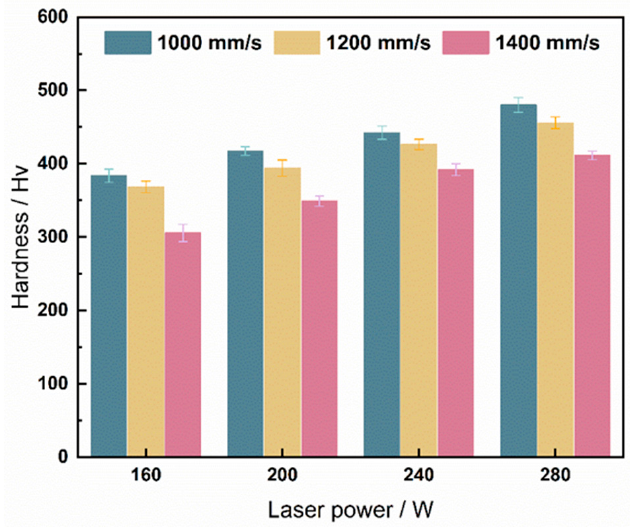
Figure 3. Vickers hardness of Ti6Al4V alloy prepared with different LPBF parameters.